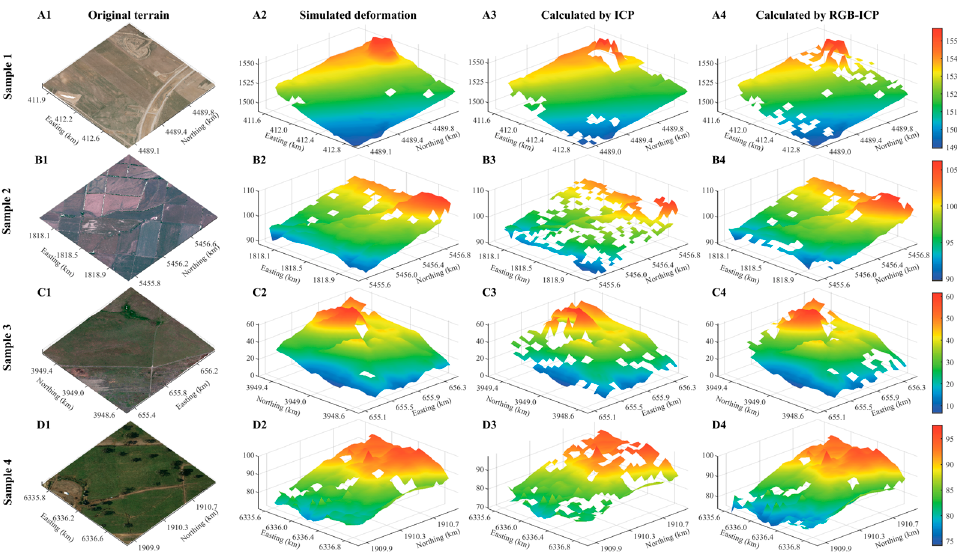
Figure 6. Three-dimensional maps of deformation-superimposed terrain obtained by applying the two algorithms (smooth terrain): ( A1 )–( A4 ) original terrain; ( B1 )–( B4 ) simulated deformation superposition results; ( C1 )–( C4 ) deformation superposition results of the ICP algorithm; ( D1 )–( D4 ) deformation superposition results of the RGB-ICP algorithm.